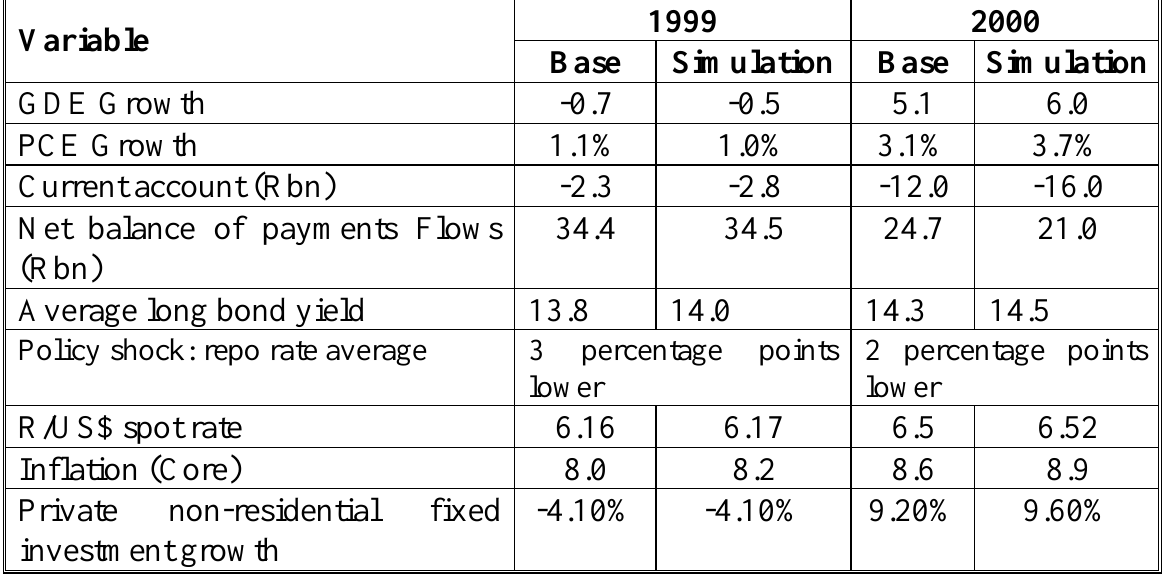
Table 4 Impact of interest rate changes on the South African